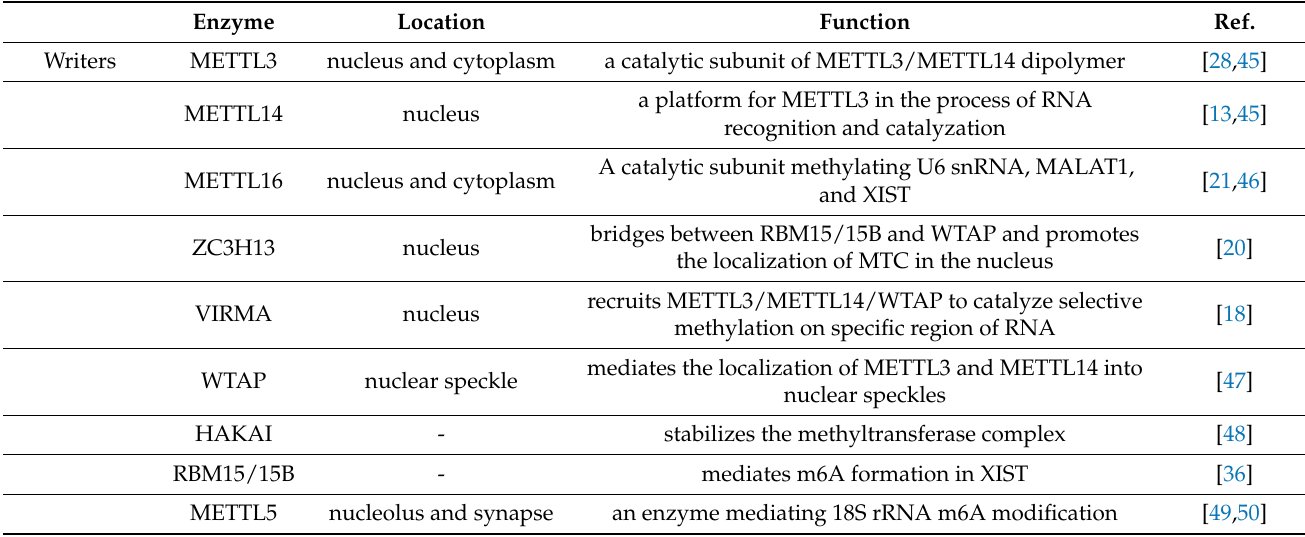
Table 1. A summary of writers, erasers, and readers in RNA